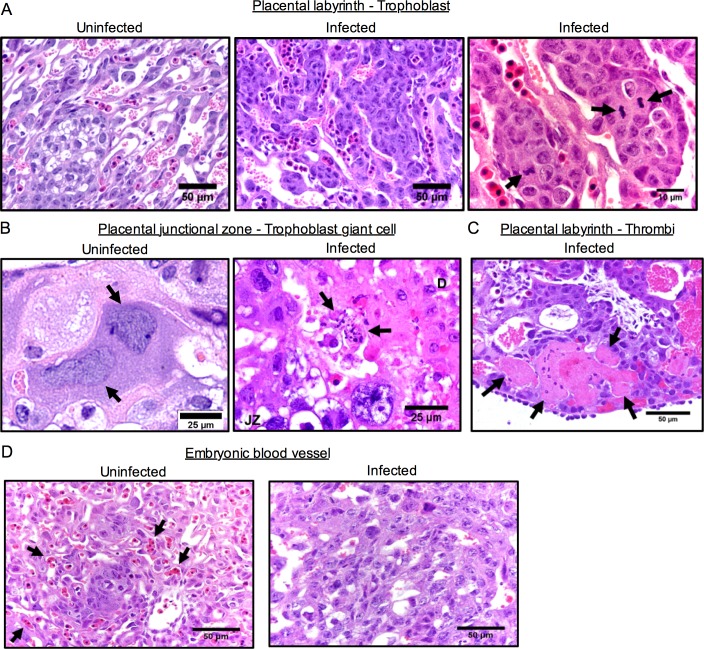
Maternal ZIKV infection induces placental damage.Pregnant dams at E9.5 were infected with 3.4 × 105 PFU of ZIKV and sacrificed at 3 dpi. Paraffin-embedded placental tissues were stained with H&E. Representative images are shown. (A) Labyrinth trophoblast hyperplasia in the placentas of infected dams. Arrows indicate mitotic labyrinth trophoblasts. Scale bar, 50 μm or 10 μm. (B) Trophoblast giant cell necrosis in the junctional zone. Arrows indicate normal tissue (left) or necrotic cell debris (right). D, decidua; JZ, junctional zone. Scale bar, 25 μm. (C) Thrombi in maternal or embryonic blood vessels in the labyrinth. Arrows indicate thrombi. Scale bar, 50 μm. (D) Loss of embryonic blood vessels, characterized by the absence of nucleated embryonic red blood cells, in the labyrinth of infected dams. Arrows indicate nucleated embryonic red blood cells. Scale bar, 50 μm.